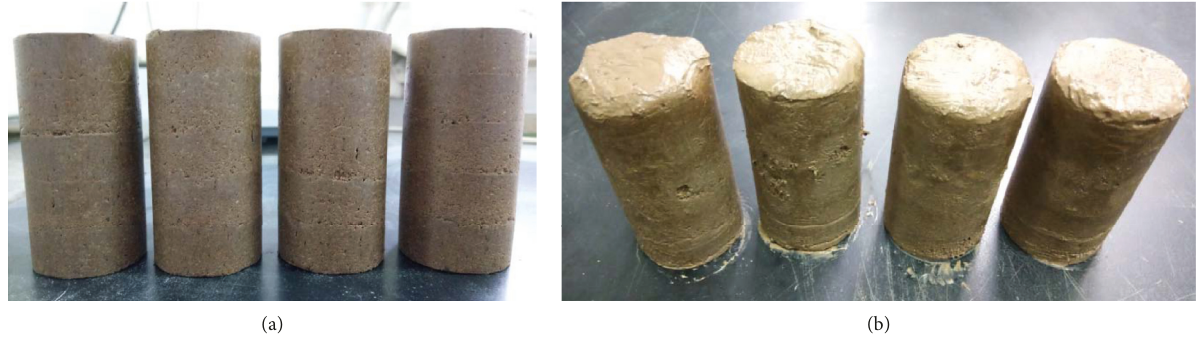
Figure 8: Specimens subsequent to 5 freeze-thaw cycles. (a) Closed system. (b) Open